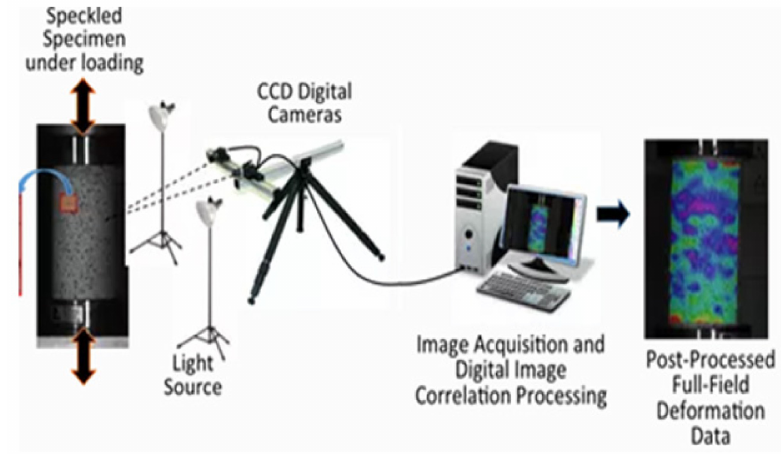
Figure 6. Experimental system of the digital image correlation method.